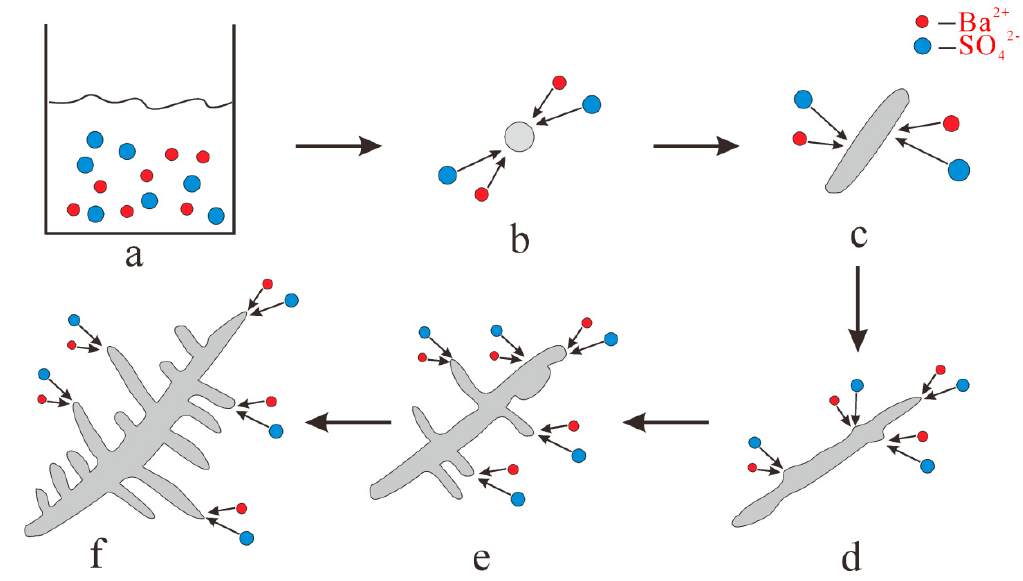
Figure 9. A schematic diagram of the formation of dendritic barite at high temperature. ( a ) Mixed solutions of sodium sulfate and barium chloride; ( b ) Granular barite; ( c ) Rod barite; ( d ) develops fine branches; ( e ) Branches continue to develop; (f) Dendritic barite.